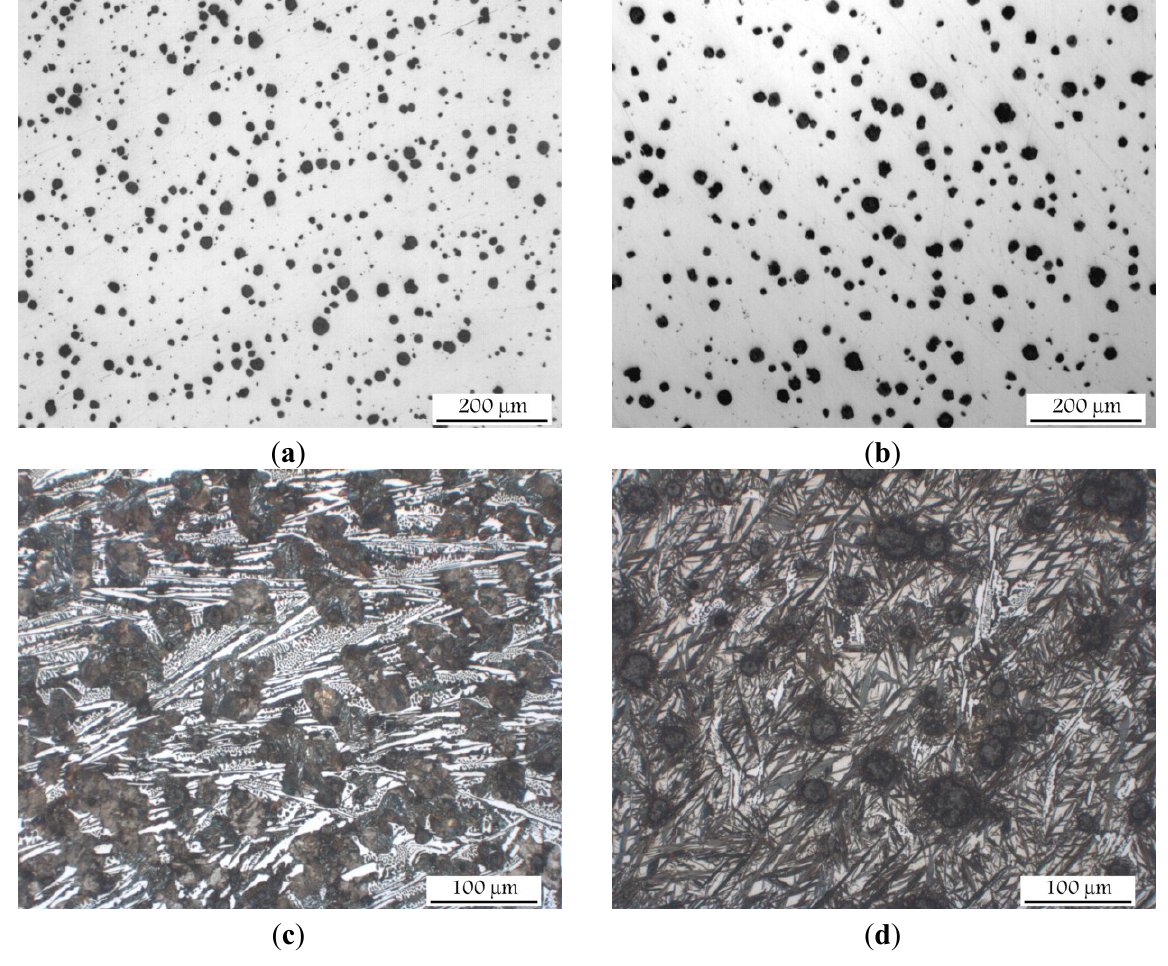
Figure 7. Different fields for different samples with the same f GA value (6.1%). ( a ) Field #5 of A11 sample. N = 527 mm −2 ; ( b ) Field #2 of A23 sample. N = 218 mm −2 ; ( c ) Field #5 of A11 sample. f S = 0.44; ( d ) Field #2 of A23 sample. f S =